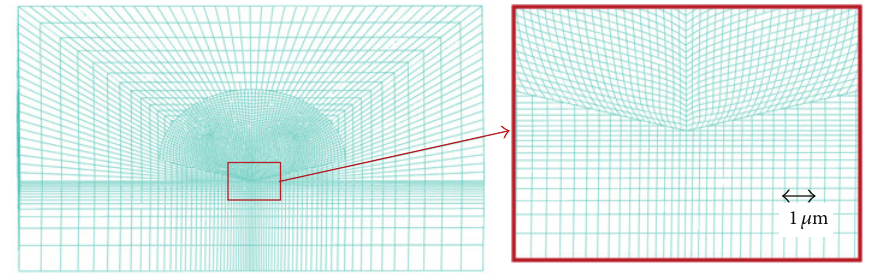
Figure 1: Finite element meshes of the numerical model of conical indentation (only half model is shown for better view). The image in the red box provides the details of the mesh in the region of contact.